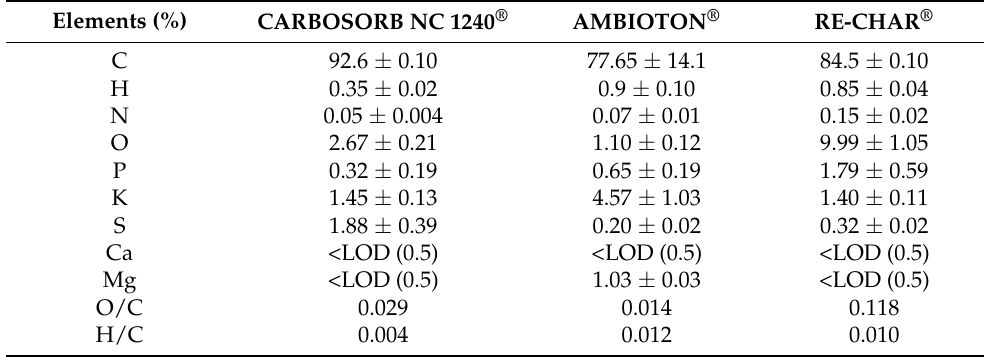
Table 7. Elemental composition of carbonaceous